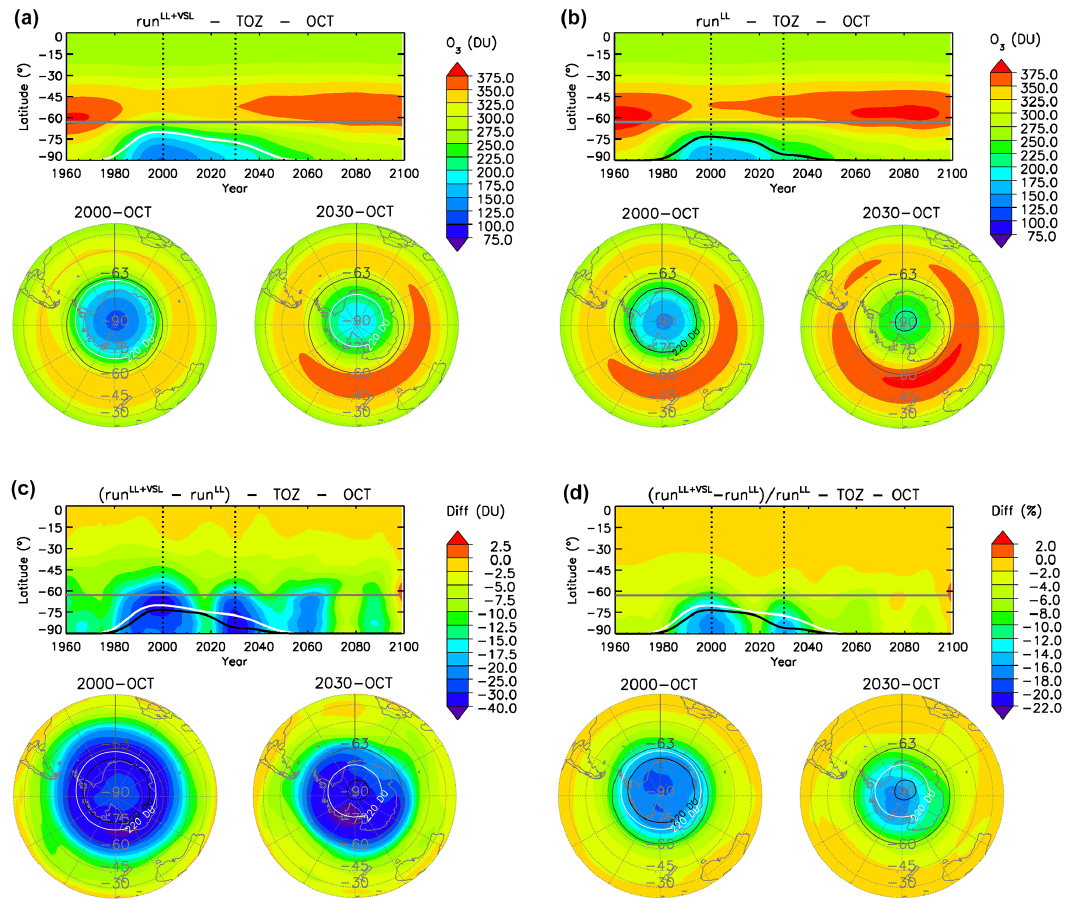
Figure 4. Ensemble mean of temporal evolution of southern hemispheric October TOZ as a function of latitude for (a) run LL + VSL , (b) run LL , (c) absolute difference between run LL + VSL and run LL and (d) percentage difference between experiments. The double inset at the bottom of each panel shows the October TOZ mean polar view during the 2000th (1995–2005 mean, left) and 2030th (2025–2035 mean, right) decades. The solid lines in each panel show the O 3 = 220DU limit defining the ozone hole area (GSFC, NASA) for each simulation (white for run LL + SL and black for run LL ) , while the solid grey lines show the 63 ◦ S parallel defining the southern polar cap (SP) over which TOZ SP is